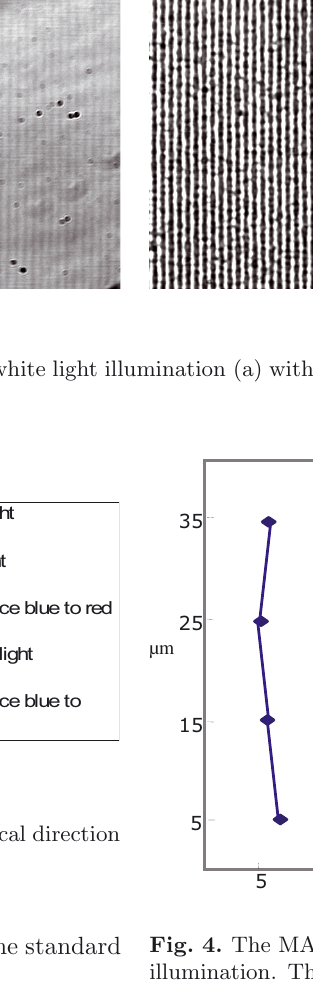
White light = 114.13 ± 24.79 nm, where σ is the standard deviation of the data. Slope of the difference in image positions between: Blue to red = –2.3 nm/ μ m; Blue to white 1 = –5.2 nm/ μ m.